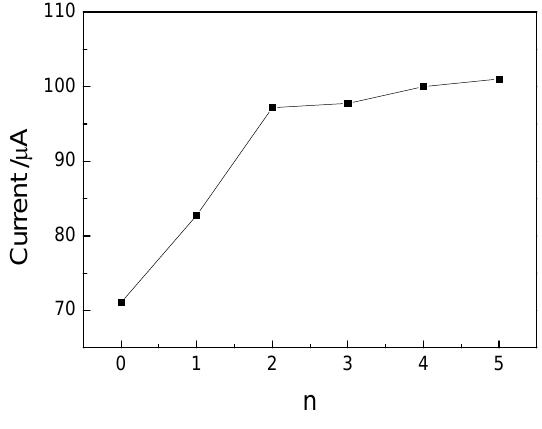
Figure 5. The comparison of peak current of the immunosensor coated with different numbers of layers.